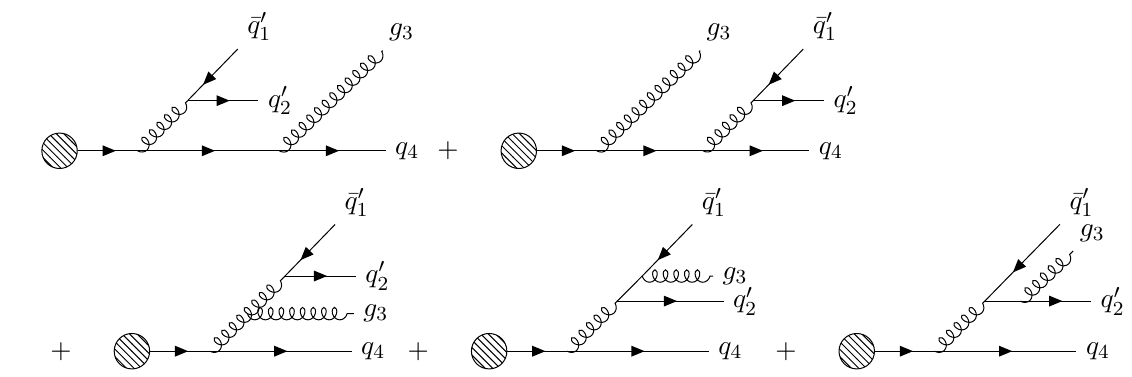
Figure 1 . The Feynman diagrams contributing to the off-shell current q → ¯ q ′ of identical quarks, q ′